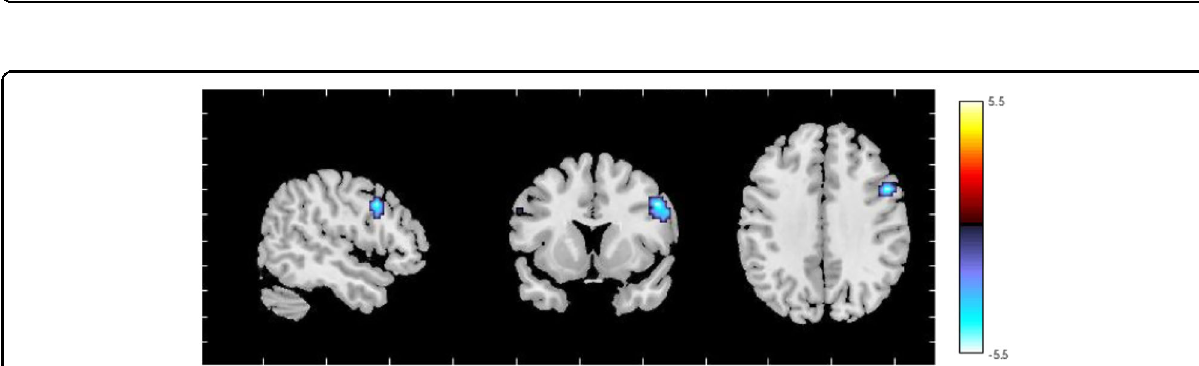
Fig. 3 Intrinsic connectivity within the executive network (IN53) was increased in women at risk for postpartum psychosis (AR) relative to control women in the right dorsolateral prefrontal cortex (peak cluster x , y , z = 51,12,36). Probability maps of intrinsic network loadings differences are thresholded at p = 0.005 and corrected for multiple comparisons with alpha = 0.05 and overlaid on the Montreal Neurological Institute brain template. Colour bar indicates t-scores. IN, Intrinsic